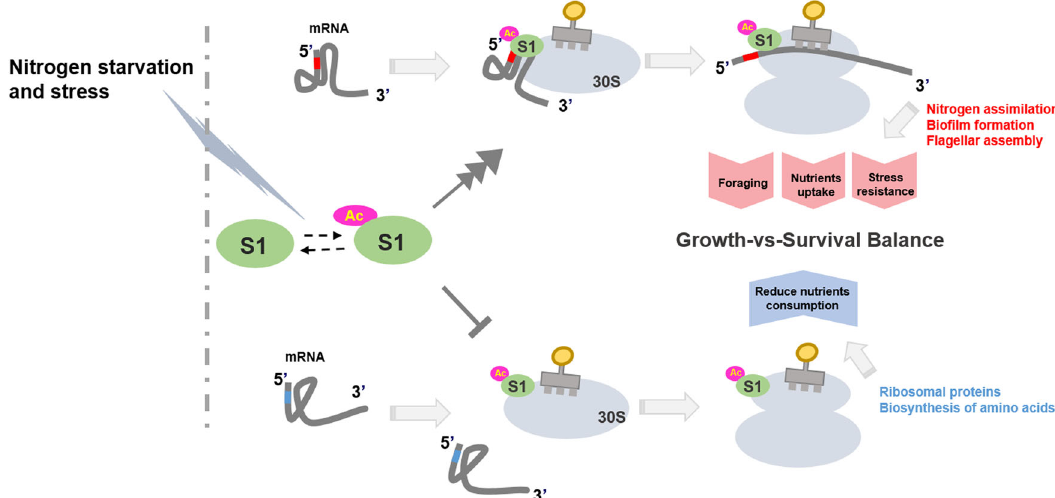
Fig. 6 Coordinated regulation of S1 acetylation-driven translation reprogramming for cell survival during nitrogen starvation. The dotted arrows represent the reversible acetylation of S1, solid arrows in dark gray represent the upregulated recruitment of mRNA and the perpendicular lines represent the downregulated